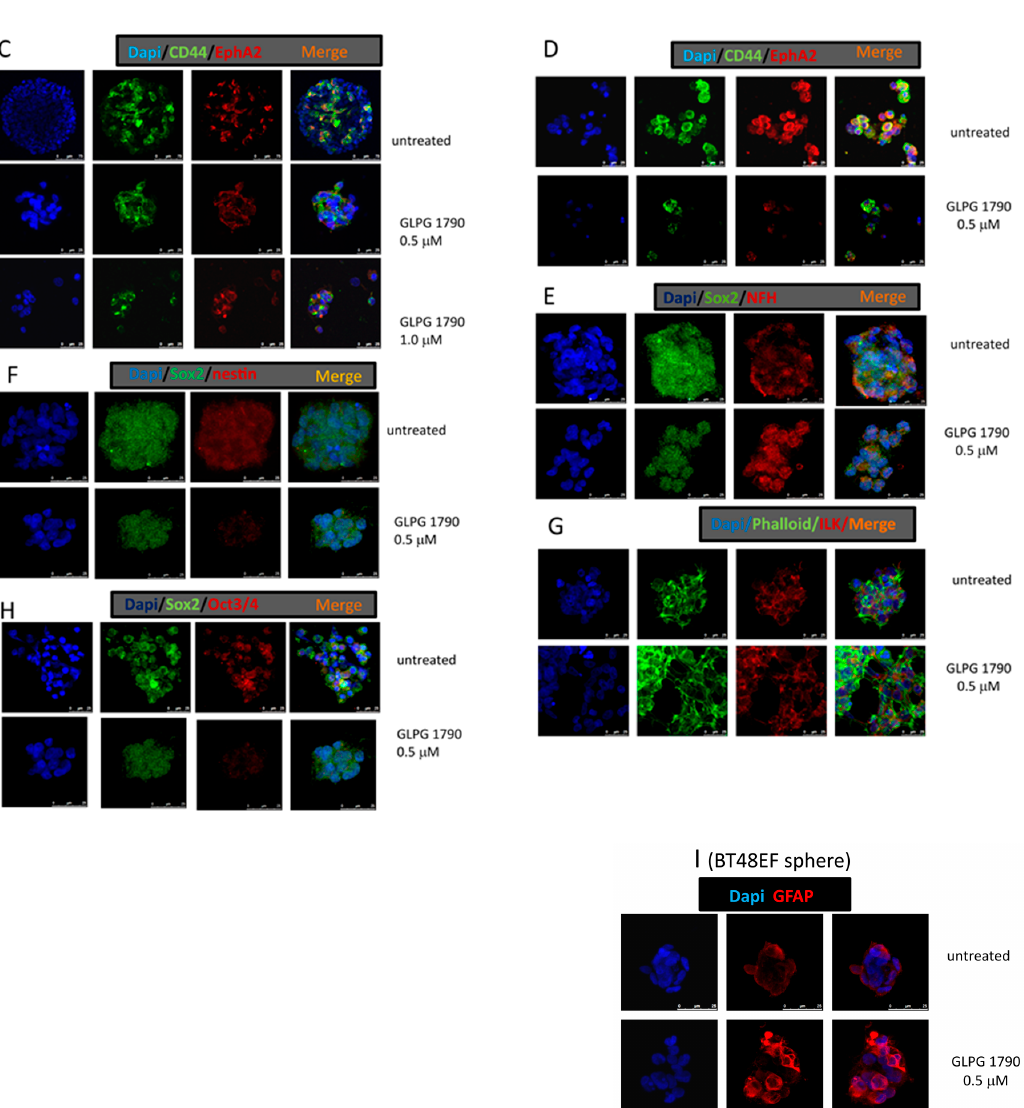
Figure 3. Phenotypic modifications in GLPG1790-treated GICs: changes in mesenchymal/stem cell marker expression. ( A ) FACS analysis performed in controls and GLPG1790-treated BT12 and BT48EF cultures. Data are representative of three separated experiments performed in triplicate and values are expressed as a percentage of positive cells present in the analyzed cell suspension. ( B ) Western blot determinations performed in control or treated BT48EF cultures. Data are representative of three different gels/experiments and lanes were charged with 40 µ g of proteins. ( C – I ) Confocal immuno-fluorescence analyses performed in BT48EF: dual CD44/EphA2 expression in cell spheres ( C ) and in single or small cell aggregates ( D ), dual Sox2/NFH expression in cell sphere cultures ( E ), dual Sox2/nestin expression in cell sphere cultures ( F ), dual phalloidin/FAK expression in adherent cells ( G ), dual Sox2/Oct 3/4 expression in cell sphere cultures ( H ), and GFAP expression in BT48EF spheres ( I ). Confocal images were collected and shown as a maximal projection of about 20 analysed spheres observed with 0.29- μ m size serial sections. Scale bar: 25 μ m.